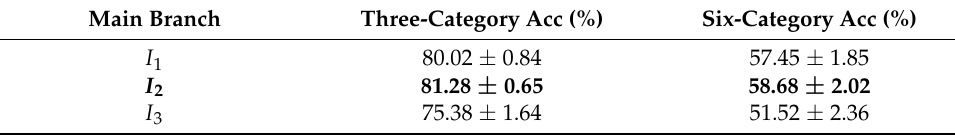
Table 8. Results of Different Main Branches in PCCAF.